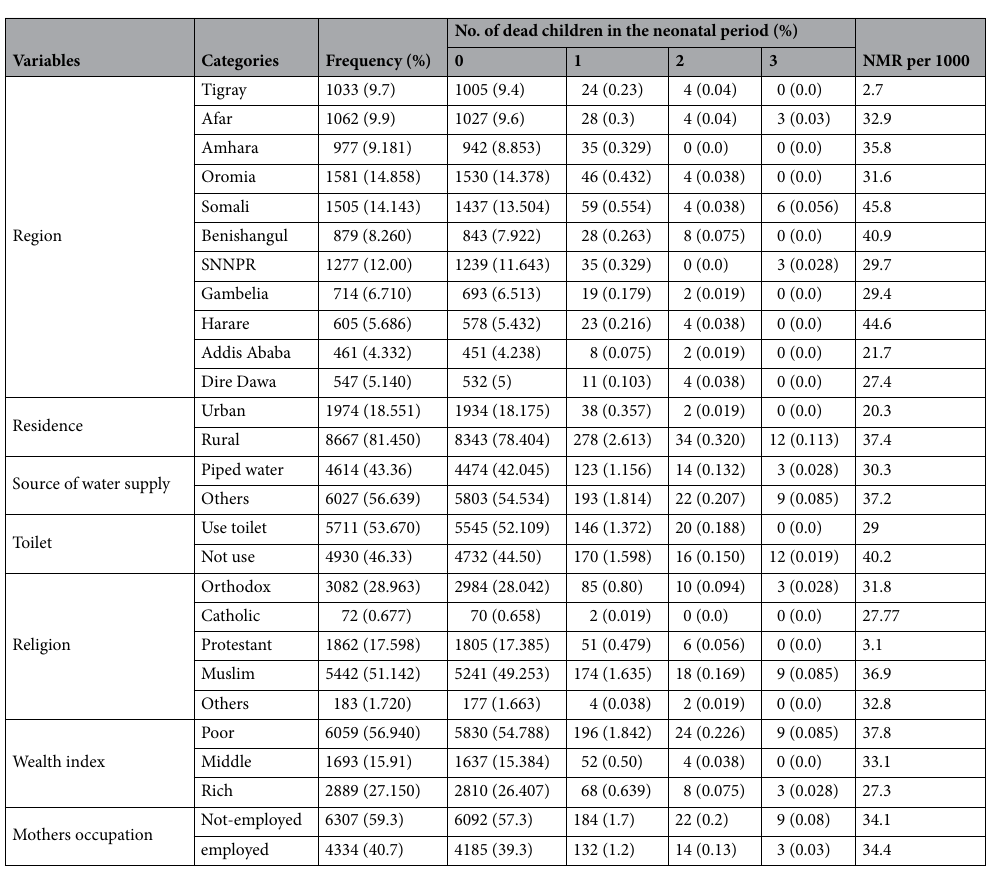
Table 2. Socioeconomic variables in the